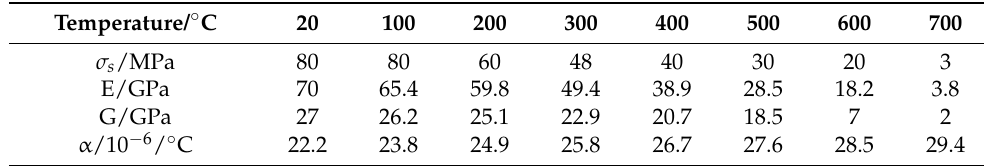
Table 4. Mechanical property parameters of 6061 aluminum alloy.